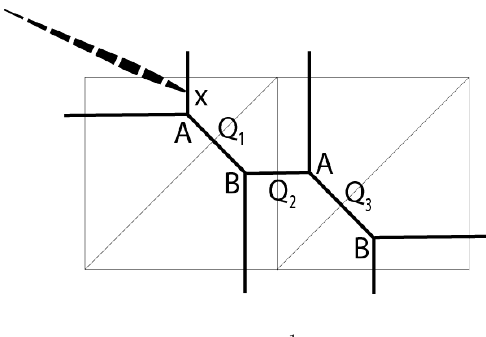
Figure 9 . Triple- P 1